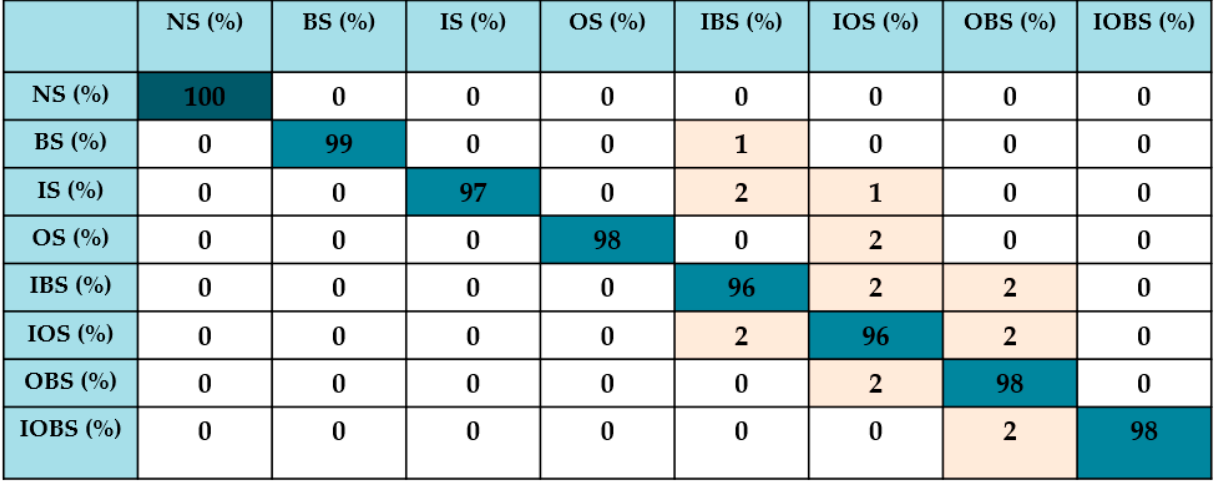
Figure 12. The average of anomaly diagnosis using the combination of proposed smooth sliding digital twin and SVM.